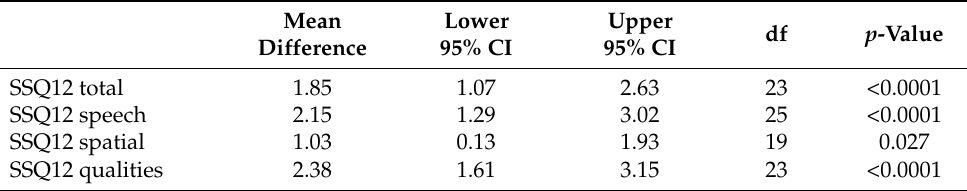
Table 4. Speech, spatial, and qualities.